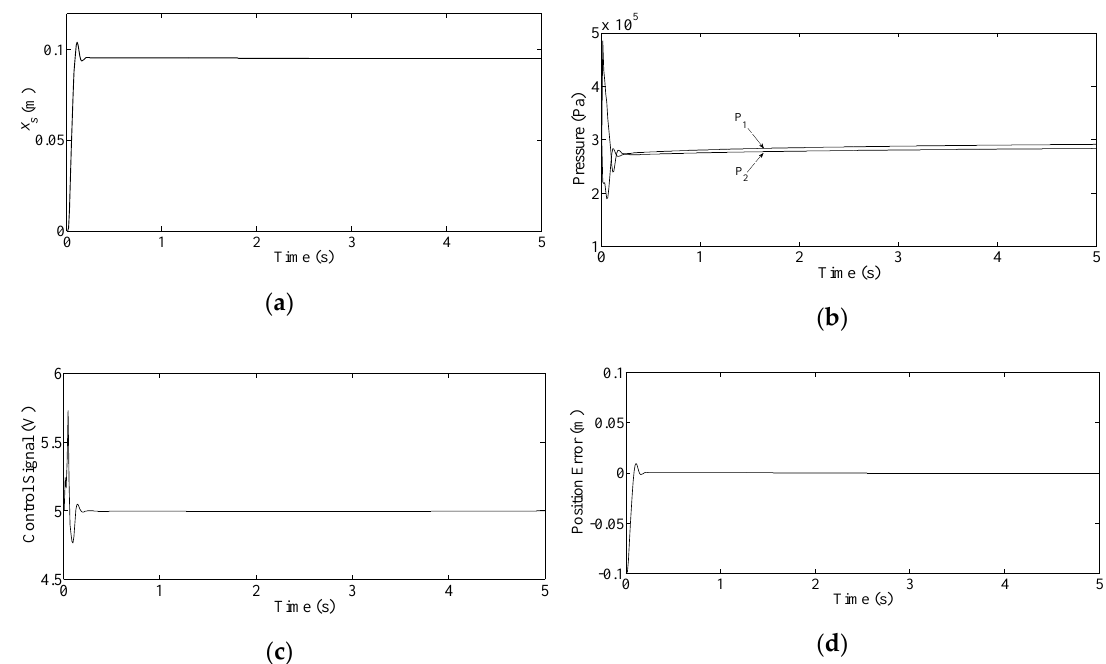
Figure 4. Step tracking with SMC: ( a ) piston position; ( b ) chamber pressures; ( c ) control signal; ( d ) position error.